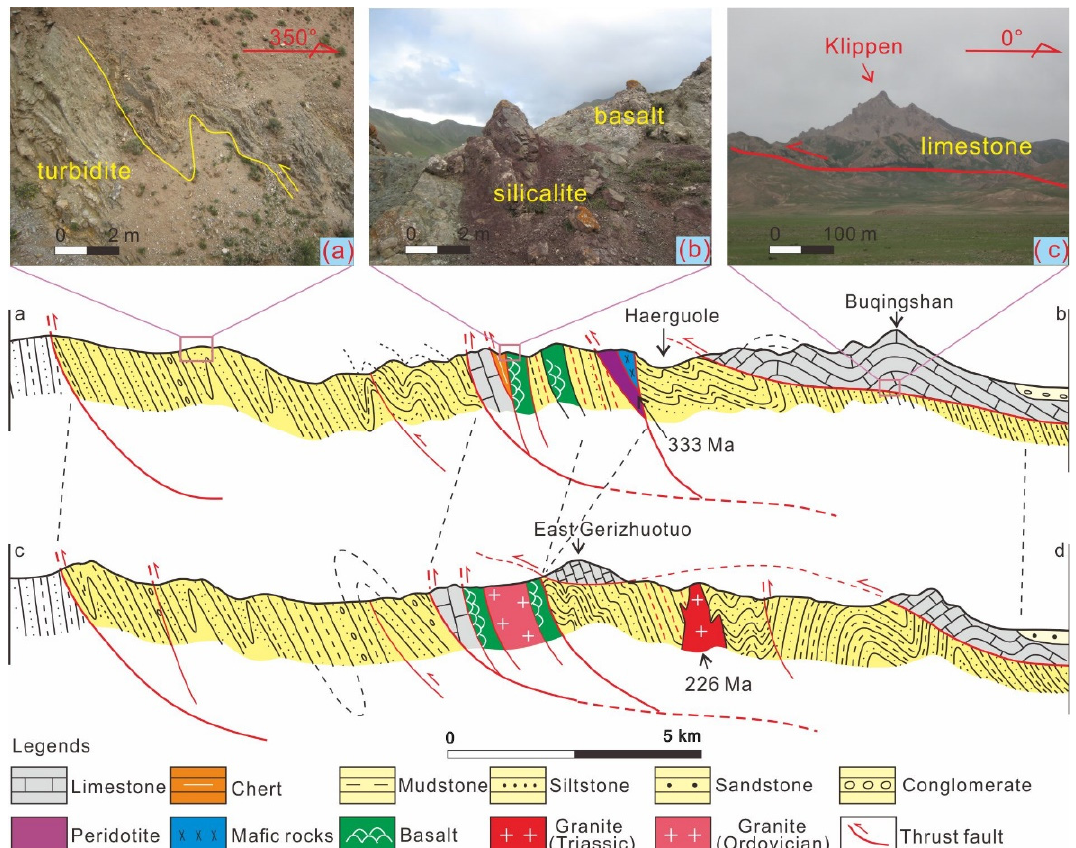
Figure 5. Geological map of the Buqingshan accretionary complex (see Figure 3 for location).